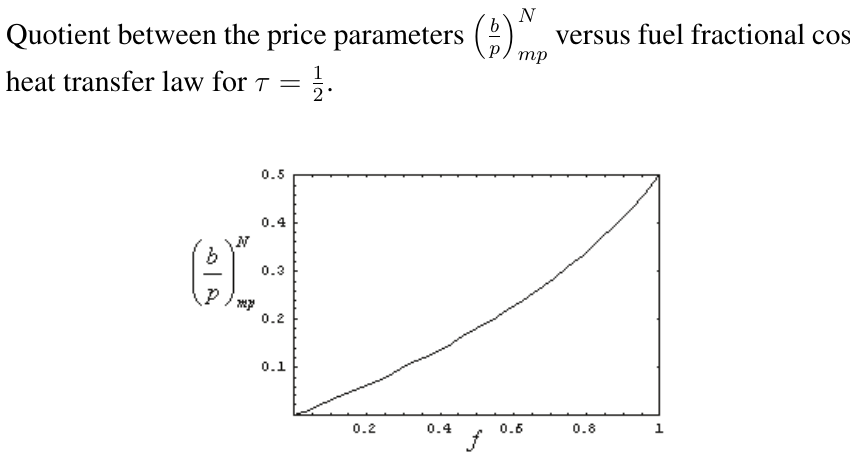
( ) N b versus fuel fractional cost ( f ) under p mp